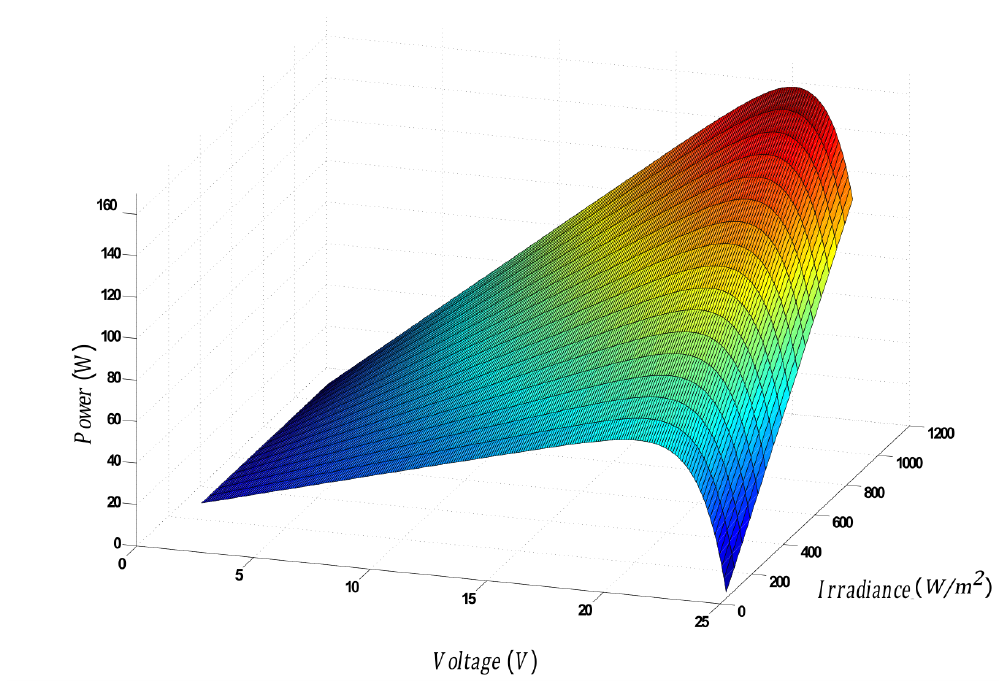
Figure 2. Characteristic PV (photovoltaic) panel curve with different irradiance ( G